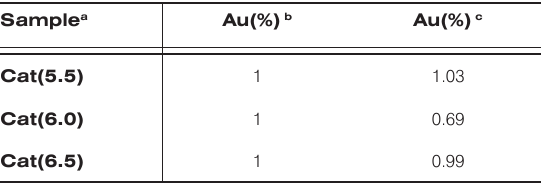
Table 1. ICP analysis on the gold content of the investigated catalysts. Sample a